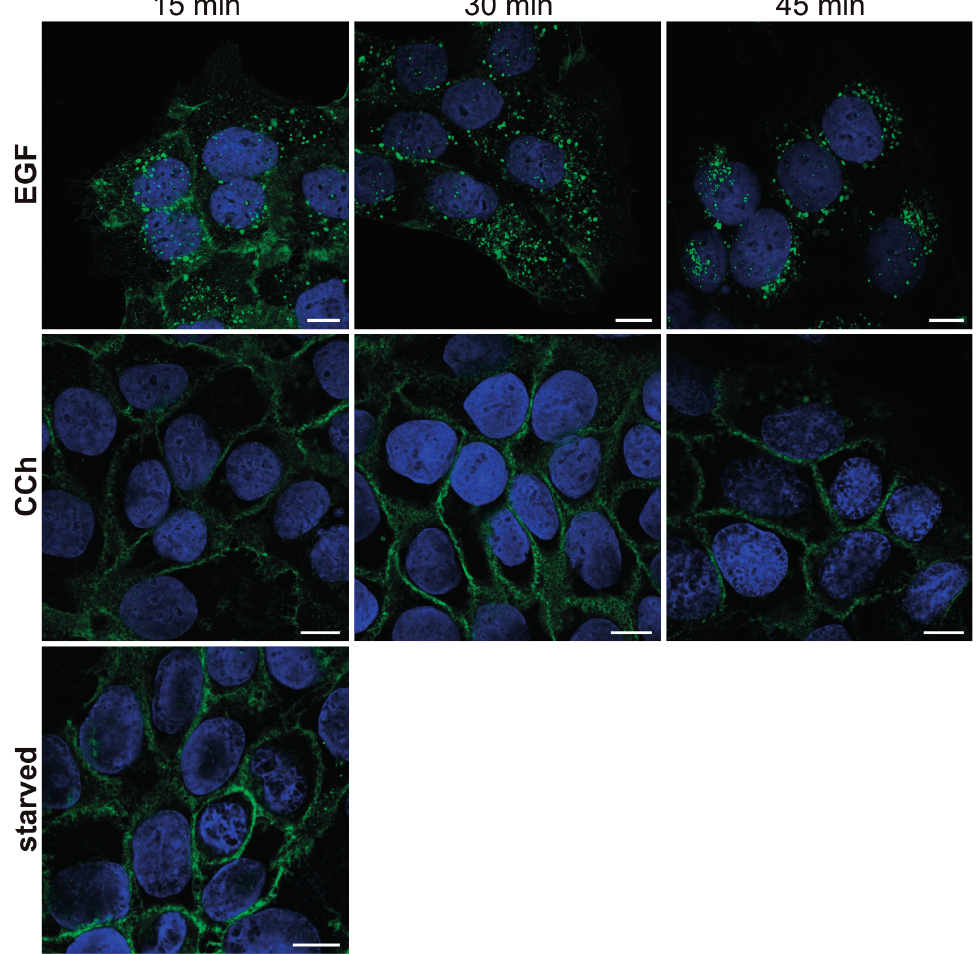
Figure 6. EGFR is internalized after EGF but not after CCh treatment. Serum-starved HaCaT cells were stimulated with 1 mM CCh or 16 nM EGF for 15, 30 or 45 min. Cells were fixed with methanol and immunostained for EGFR. Nuclei are shown in blue (DAPI staining). The results are representative of three independent experiments. Scale bar: 10